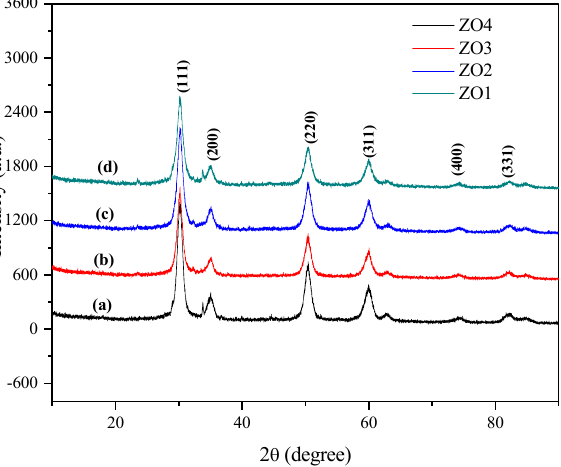
Fig. 1. (a)-(d): PXRD Pattern for ZrNPS (a) ZO1 and, (b) ZO2, (c) ZO3 and (d) ZO4 nanoparticles using Basella Alba raw juice as Natural